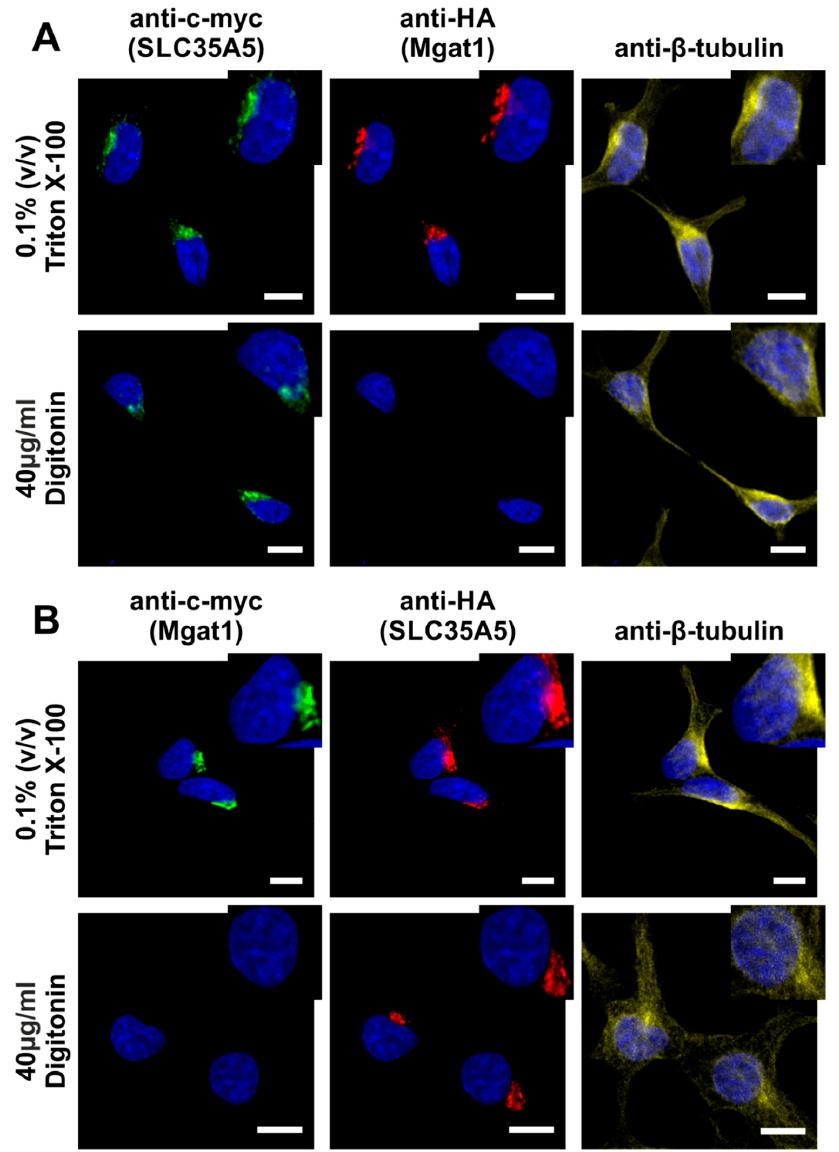
Figure 7. Determination of SLC35A5 C-terminus topology. HepG2 cells simultaneously overexpressing C-terminally tagged SLC35A5 and C-terminally tagged mannosyl ( α -1,3-)-glycoprotein β -1,2- N -acetylglucosaminyltransferase (Mgat1) were subjected to immunofluorescence staining. ( A ) SLC35A5 was detected with chicken anti-c-myc antibody (green) and Mgat1 was counterstained with rabbit anti-HA antibody (red) or ( B ) SLC35A5 was detected with rabbit anti-HA antibody (red) and Mgat1 was counterstained with chicken anti-c-myc antibody (green). Permeabilization of both plasma and Golgi membranes was performed with 0.1% ( v / v ) Triton X-100. To selectively permeabilize the plasma membrane, 40 µg/mL digitonin was employed. As a positive control of plasma membrane permeabilization, β -tubulin was detected using mouse antibody (yellow). Cell nuclei were counterstained with DAPI. Scale bar = 10 µm.